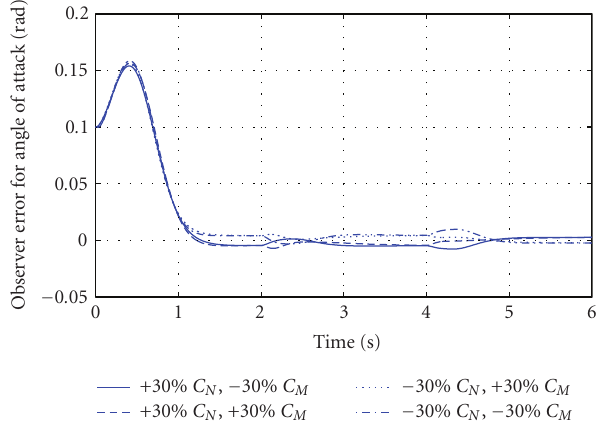
Figure 12: Climb rate, ˙ h , with/without observer.